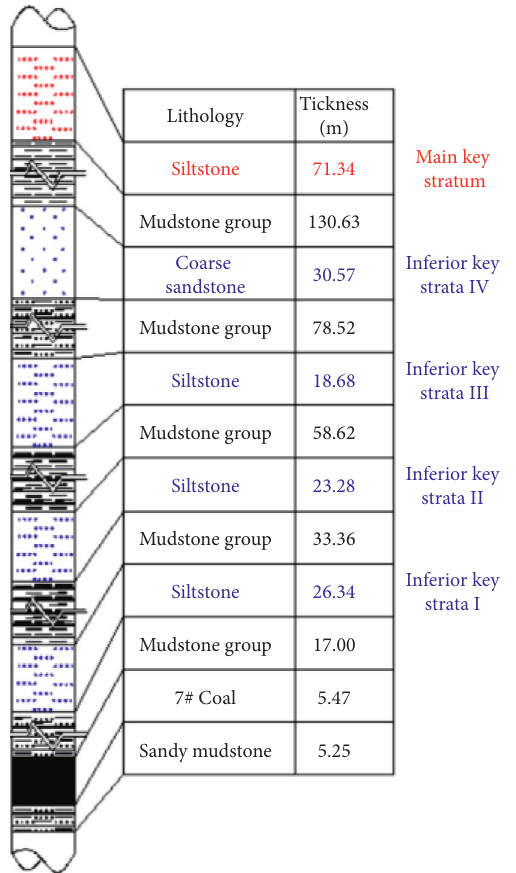
Figure 2: Distribution of main primary and inferior key strata in the asymmetric coal pillar area (borehole Y13#).